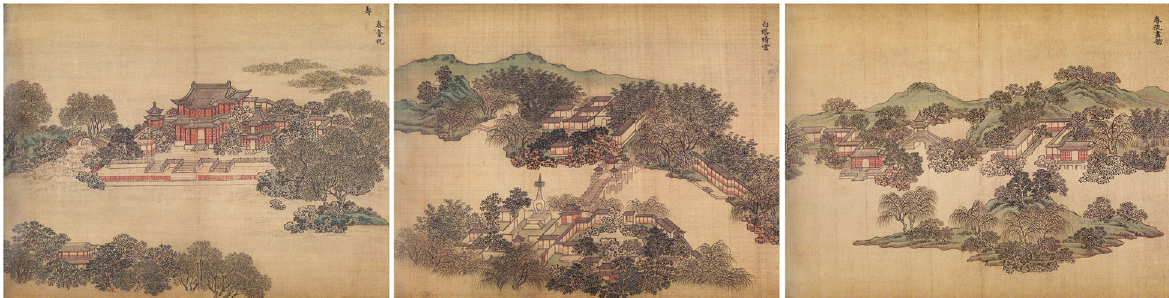
Fig. 3 Atlas of Great Landscape of the Gardens in the South of the Yangtze River, 1760, landscapes in Slender West Lake (Source: Yangzhou